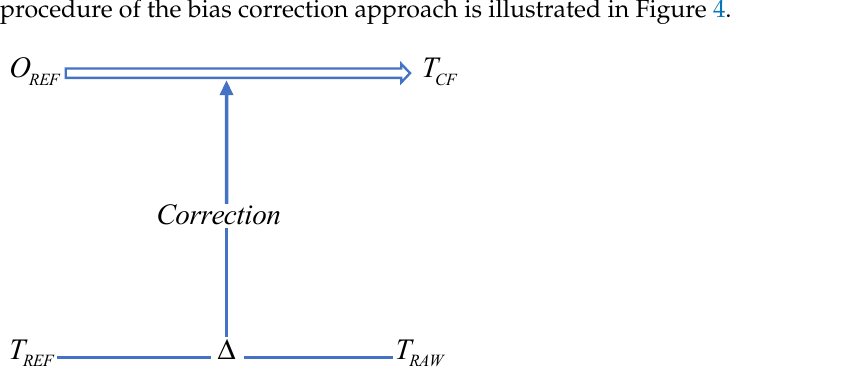
Figure 4. Schematic of the bias improvement system.